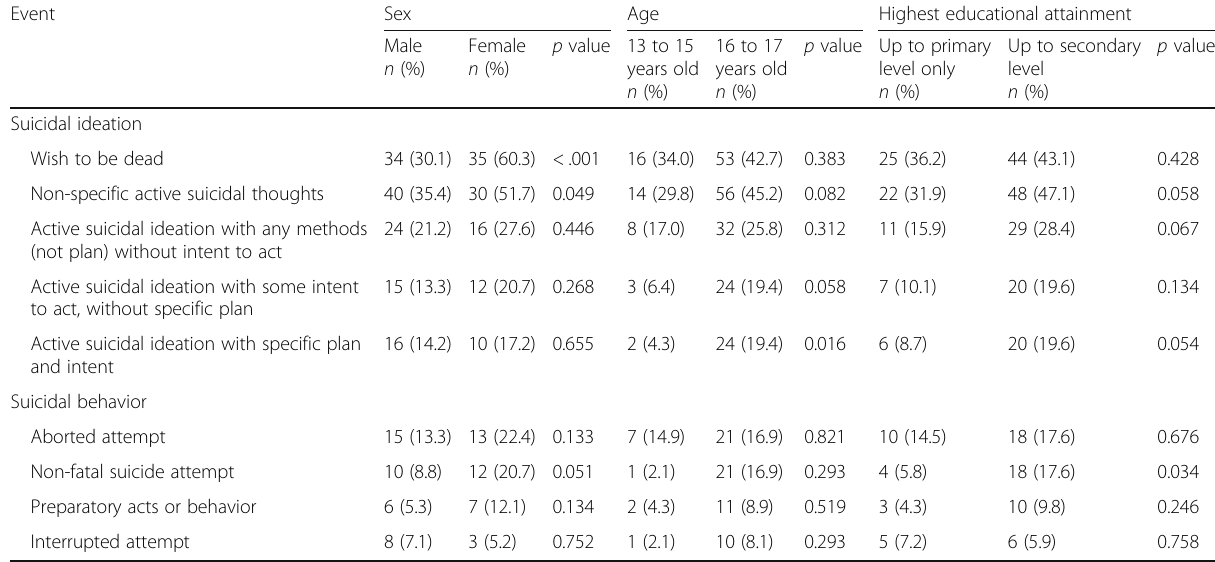
Table 3 Comparison of surveyed learners with suicidal ideation and behaviors according to sex, age, and highest educational attainment